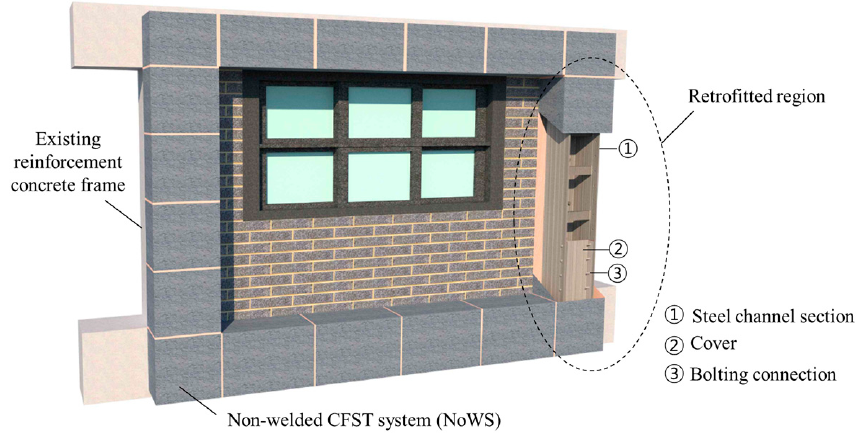
Figure 1. Non-welded CFST system (NoWS) retrofit scheme for an RC frame.